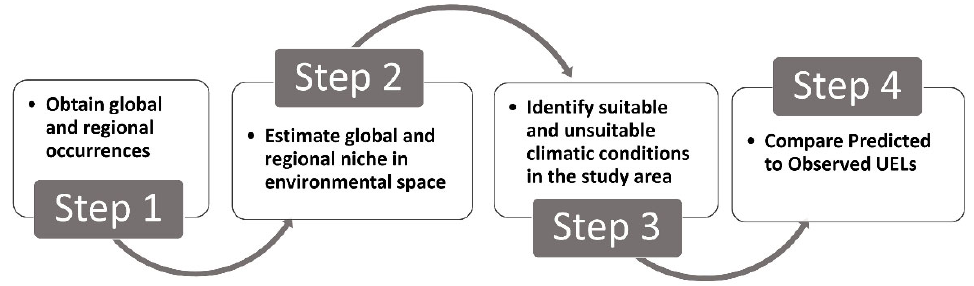
Figure 3. Workflow diagram used to estimate the predicted upper elevational limit (UEL) for a set of alien species in mountain ecosystems of central Chile.